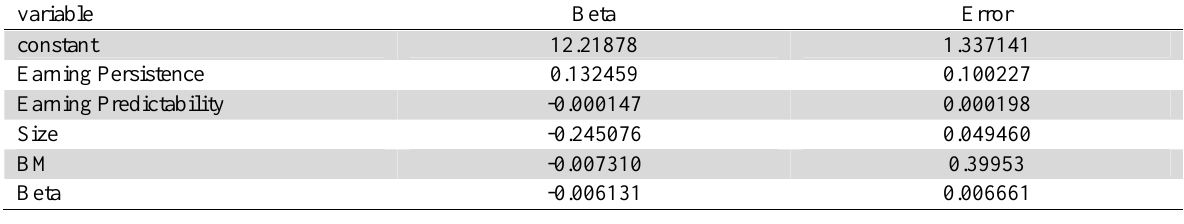
Regression Estimation